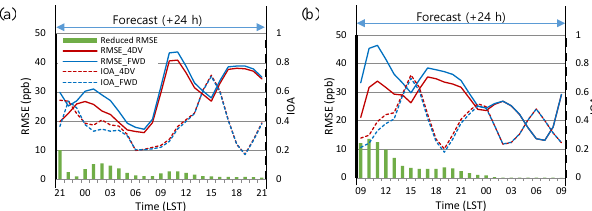
Figure 19. Time variations of RMSE (solid lines) and IOA (dashed lines) for 24h forecast after (a) daytime and (b) nighttime assimi- lation. Red and blue lines indicate the statistical results for 4D-Var run (4DV) and forward run (FWD), respectively. Hourly reduced RMSE values are also marked along the axis of